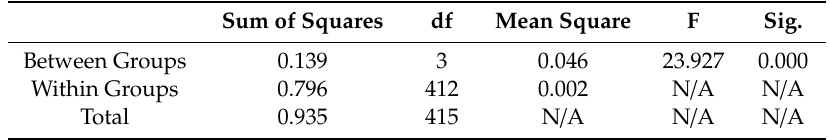
Figure A2. Lipid content of dry microalgae biomass from wastewater with partially and completely submerged electrodes in the cathode chamber. Table A1. ANOVA analysis for working voltages (V) generated by the microbial fuel cell (MFC) reactors with the cathode electrodes submerged at the proportions of 25%, 50%, 75%, and 100%.